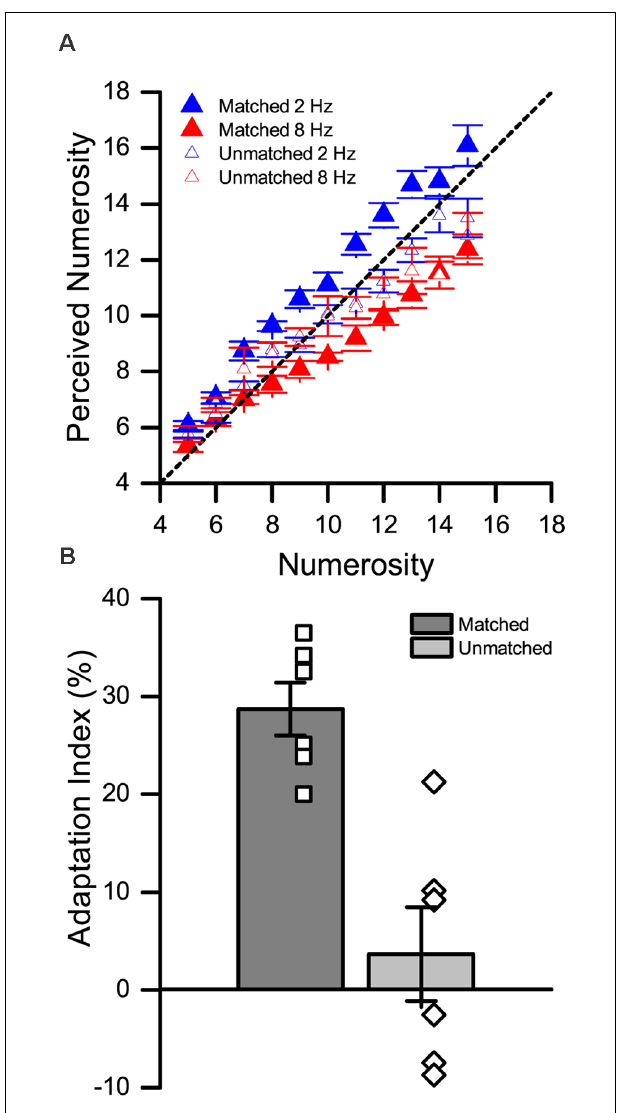
FIGURE 3 | Spatial selectivity in the cross-modal tactile-visual (Tact-Vis) condition. (A) Average numerical estimates for each numerosity presented in the low (blue triangles) and high (red triangles) matched condition. The empty symbols correspond to the unmatched condition and the filled symbols to the matched condition. (B) Average adaptation effect indexes (AIs) in the matched (dark gray bar) and unmatched (light gray bar) condition. The empty symbols show the individual estimates of the effect. Error bars represent